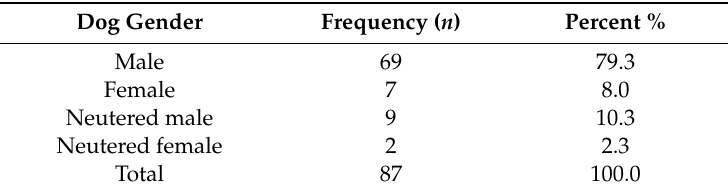
Table 6. Gender of dogs aggressive towards humans.